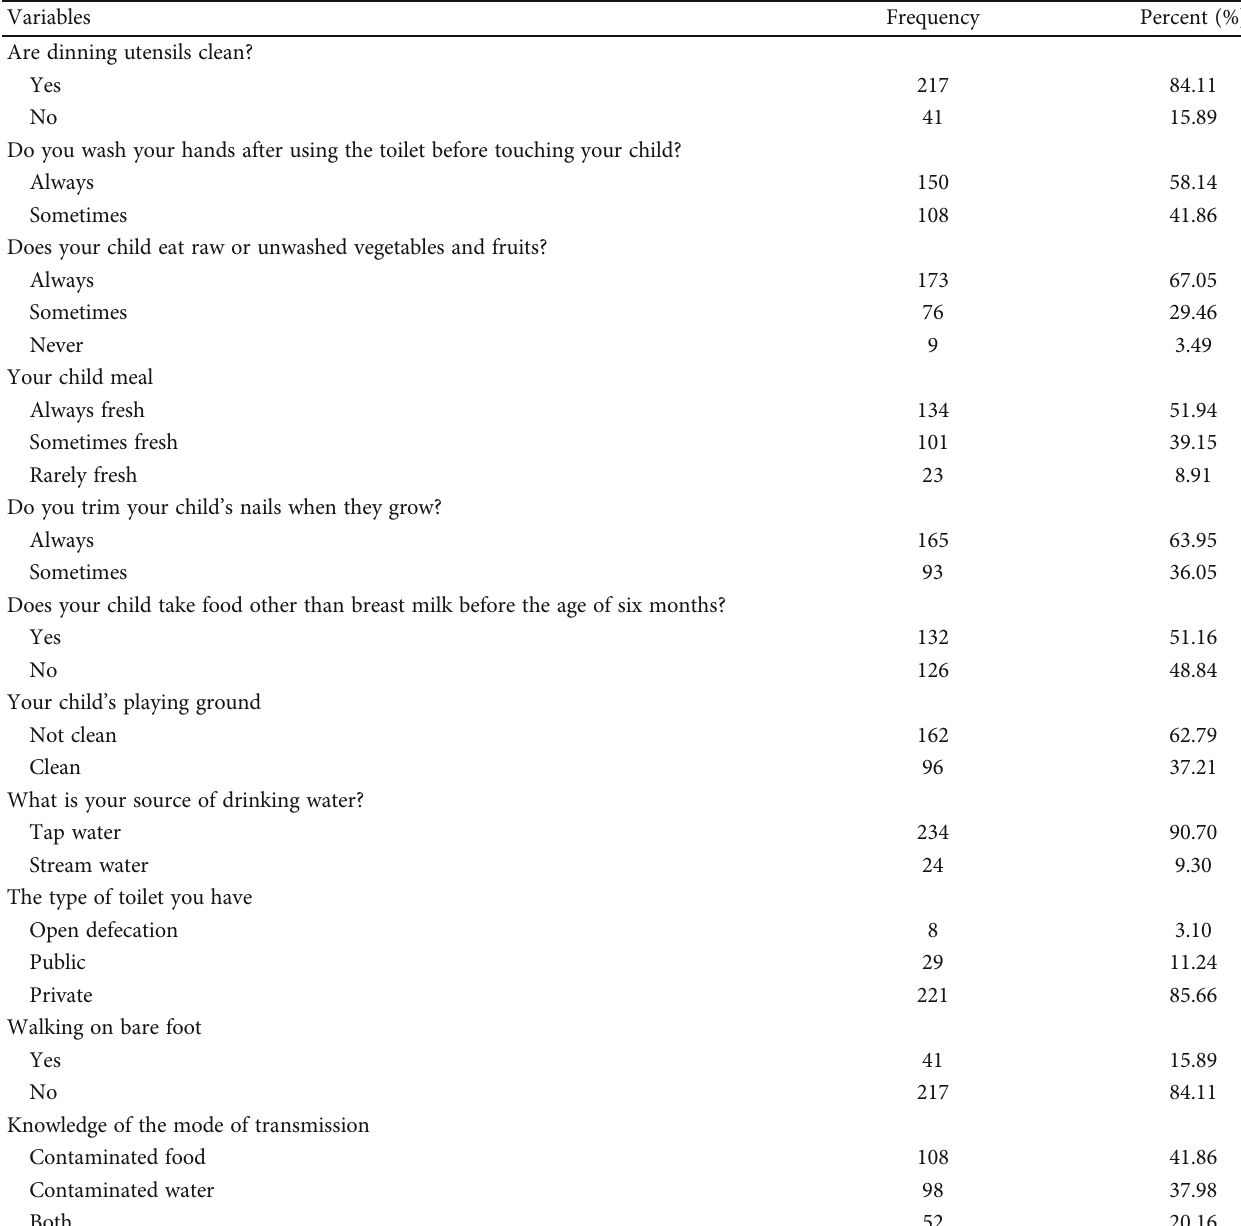
Table 3: Characteristics of food, personal, and environmental hygiene of participants at Debre Tabor comprehensive specialized hospital, Northwest Ethiopia, 2021 ( n = 258